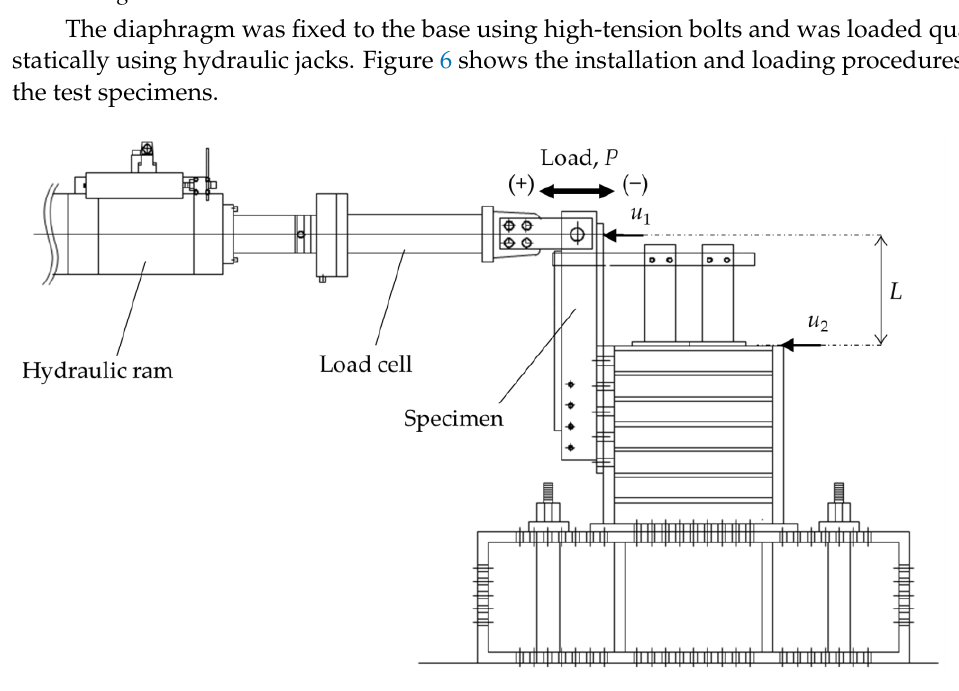
Figure 6. Positions for the load application and displacement measurements.